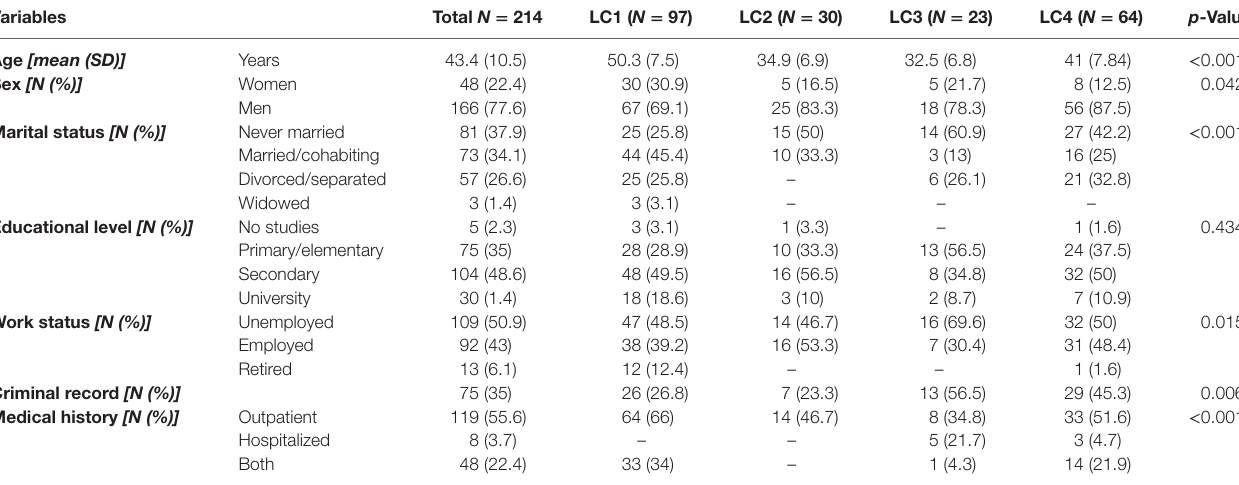
Table 6 | Sociodemographic variables in addicted patients according to latent classes.